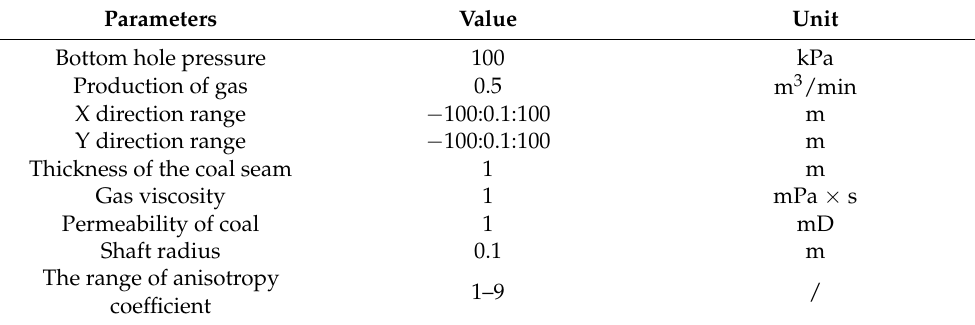
Table 1. The parameters used for the case without fractures. Parameters Value Unit Bottom hole